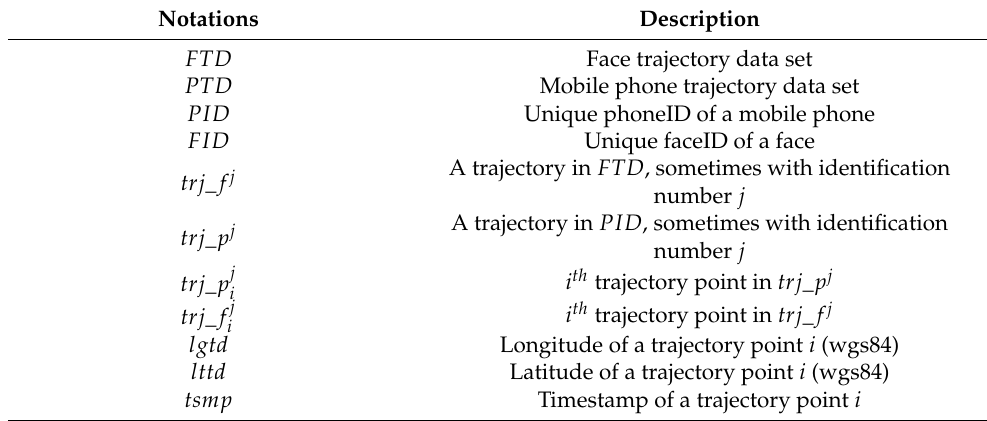
Table 1. Notation and